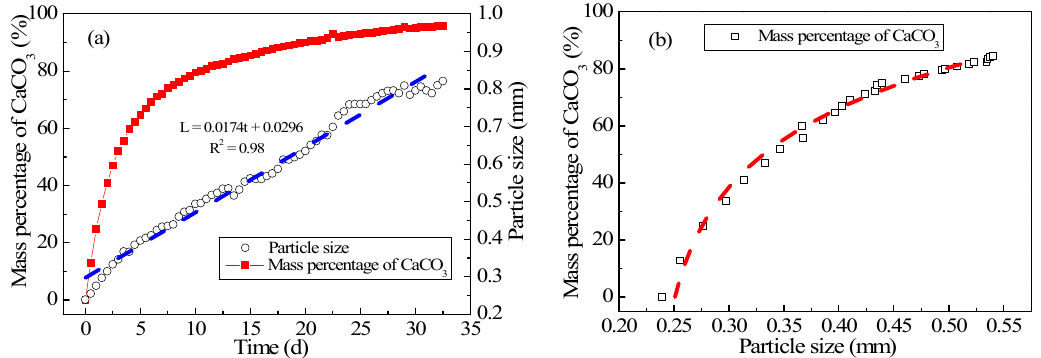
Figure 6. ( a ) Change in the average pellet size and the percentage of CaCO 3 with running time at the bottom of CPFB reactor, and ( b ) Relation between the average pellet size and the percentage of CaCO 3 .